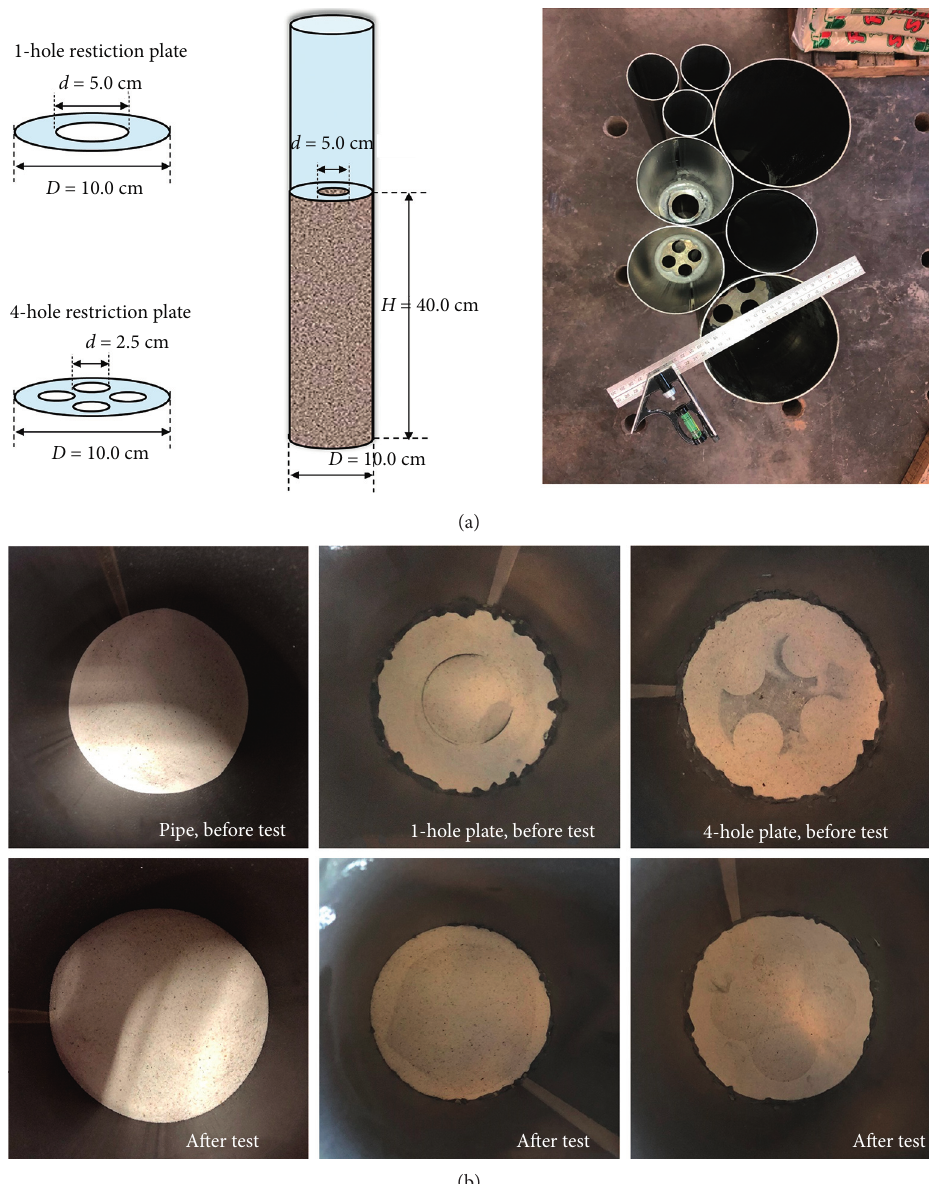
Figure 6: Soil plug resistance test with different restriction plates: (a) model dimensions and (b) top view of soil plug before and after the test.